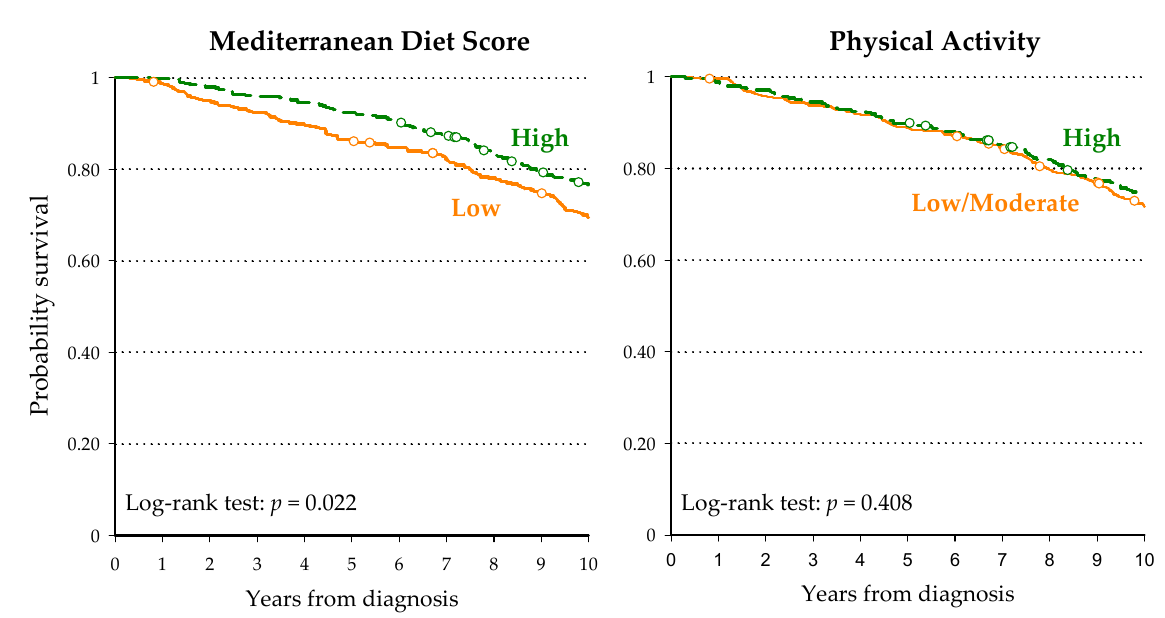
Figure 1. Kaplan–Meier estimates of survival in 777 men diagnosed with prostate cancer, according to Mediterranean Diet Score and physical activity. Table 2. Kaplan–Meier estimates of survival and hazard ratios (HR) of death and corresponding 95% confidence intervals (CI), among 777 men diagnosed with prostate cancer, according to Mediterranean Diet Score and physical activity. Italy, 1995–2002.